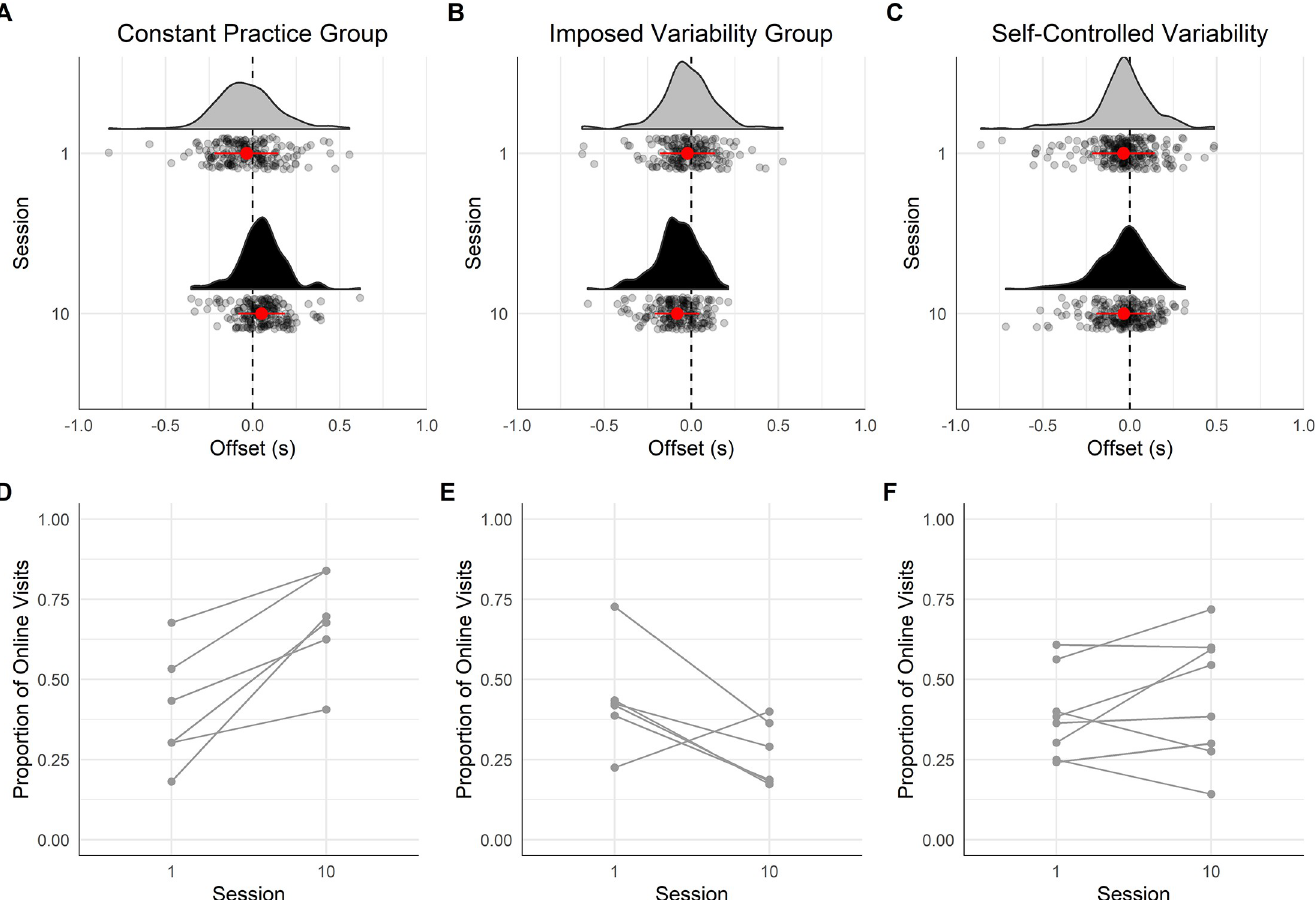
Fig 4. Offset time of the last gaze visit before the hand contacted the handhold for the three groups on the training route. In (A), (B) and (C), the vertical dashed line shows the time the hand touched the handhold, each point represents one gaze visit, the half violin shows the density of points, the red/grey point with the error bar refers the mean of all the gaze visits and the standard deviation around the mean. The color of the half violin refers to the learning session: in grey, session 1 and in black, session 10. (D), (E) and (F) displays the individuals’ proportion of online visits on session 1 and 10. (A) and (D) show data for the constant practice group, (B) and (E) for the imposed variability group, and (C) and (F) for the self-controlled variability group.